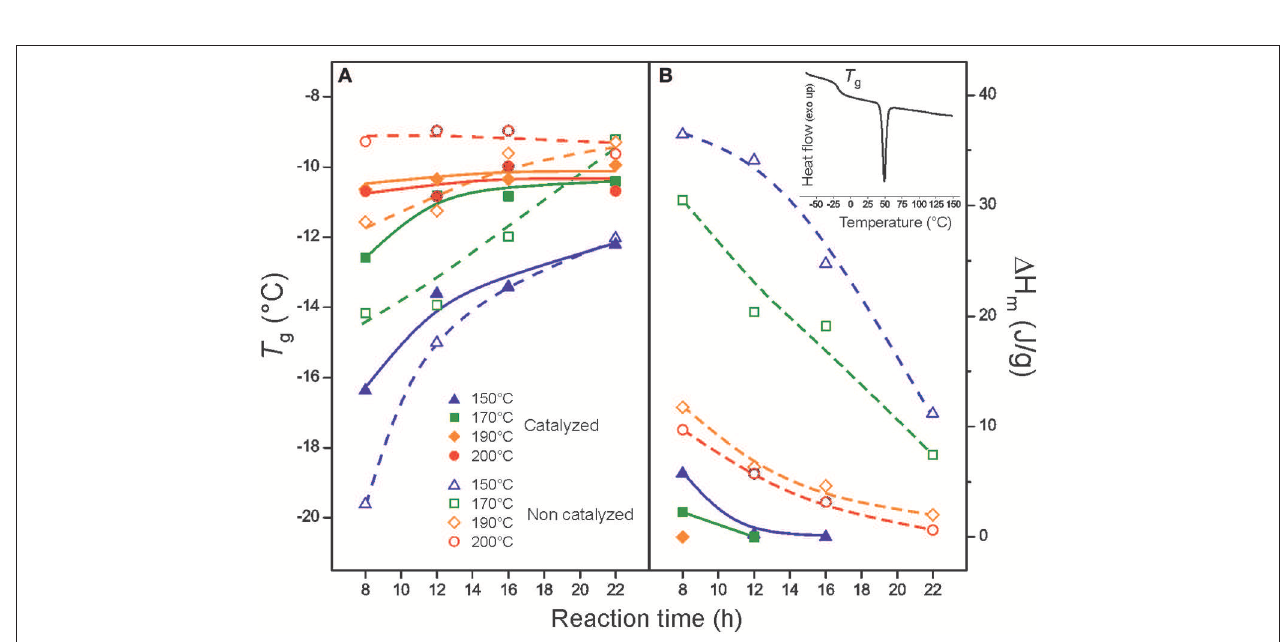
FIGURE 3 | (A) T g and (B) melting enthalpy ( 1 H m ) values of polyaleuritates as a function of temperature and reaction time for both catalyzed (filled symbols) and non-catalyzed (open symbols) series. The inset in (B) shows the DSC thermogram of the polyaleritate synthesized at 170 ◦ C during 8h with a low temperature glass-transition and a melting peak ∼ 50 ◦ C as a representative